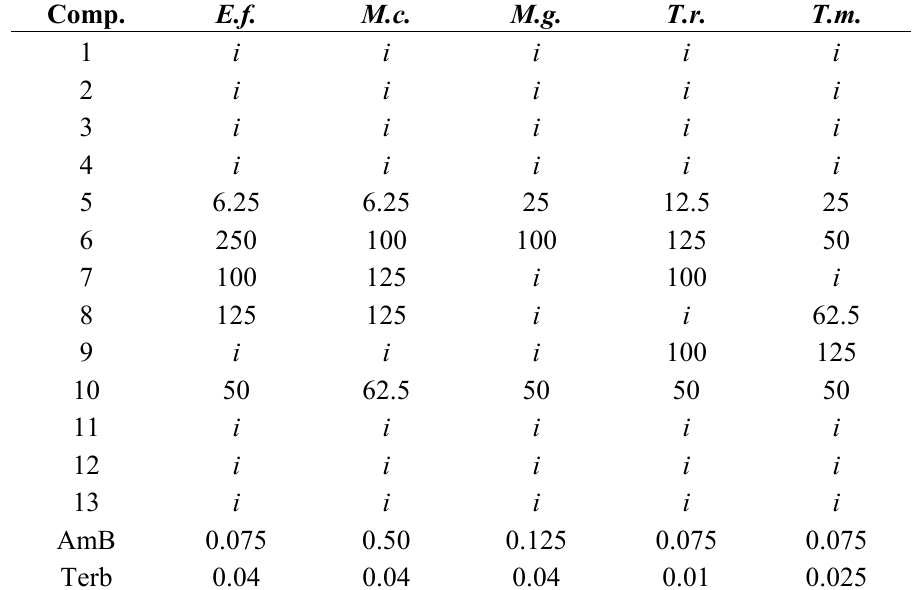
Table 1. Antifungal activity (MIC values,  g/mL ) of phthalazinones 1 – 13 against dermatophytes. Comp.